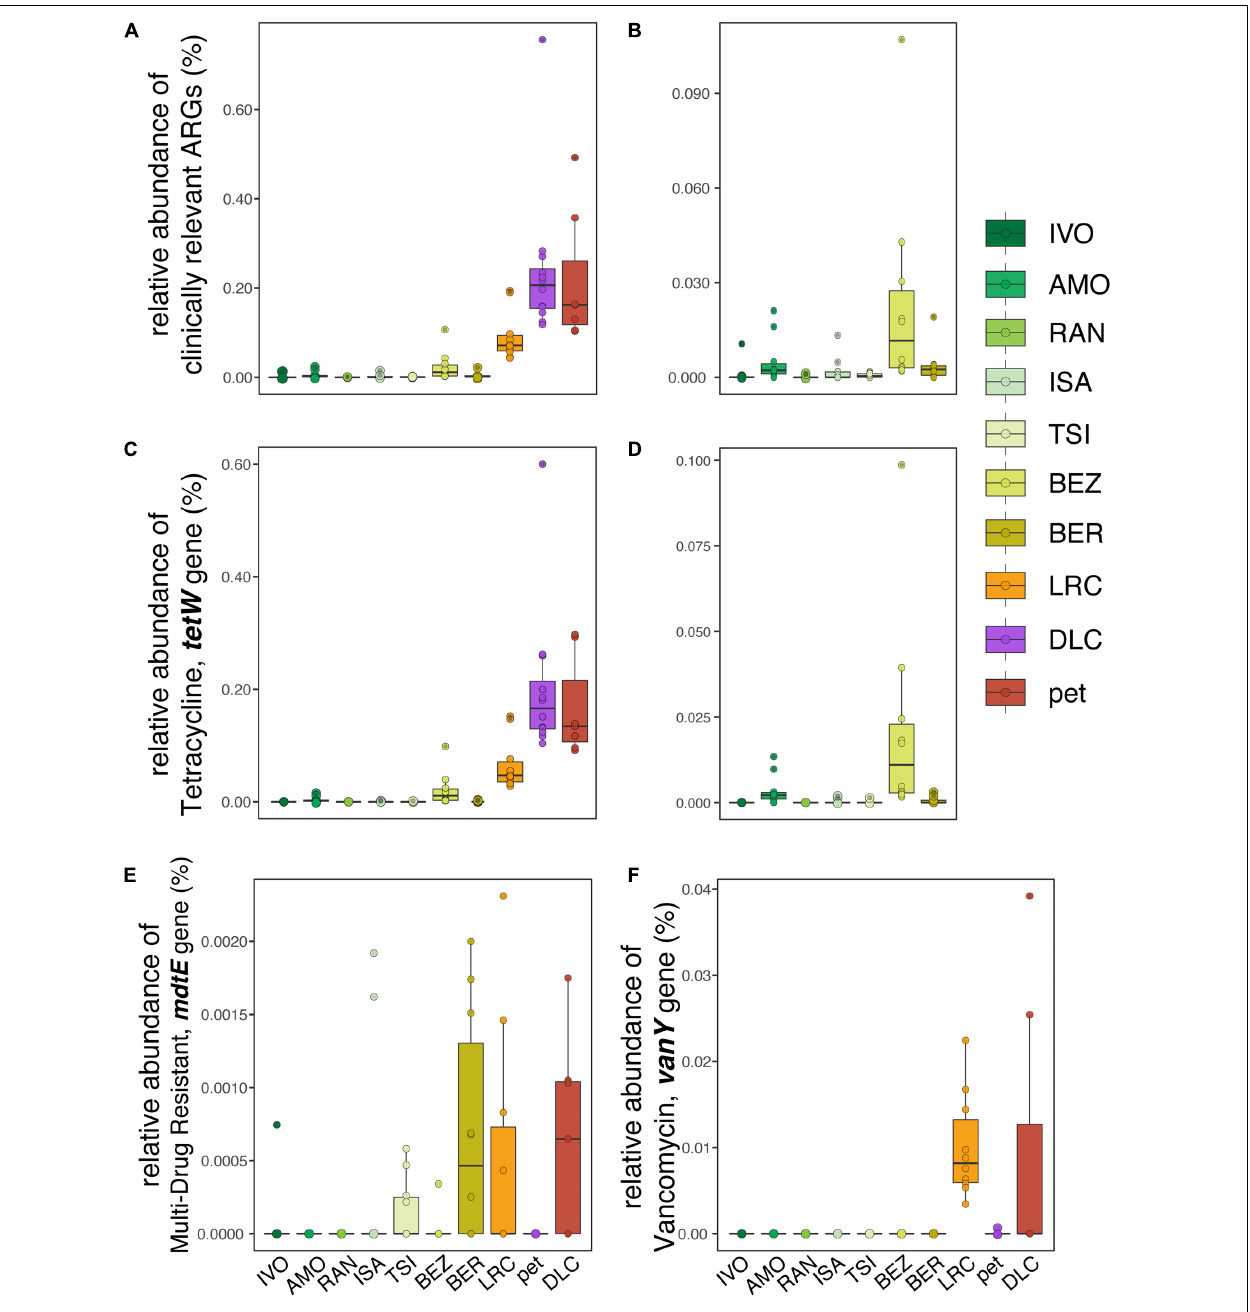
FIGURE 4 | Relative abundances of (A,B) clinically relevant ARGs, including (C,D) tetracycline resistance gene, tetW in the gut microbiota of (A,C) all ring-tailed lemurs ( Lemur catta ) versus (B,D) only wild lemurs, across sites ranked by increasing level of anthropogenic disturbance (see Table 1 ). Also shown are the relative abundances of (E) multi-drug resistant gene mdtE and (F) vancomycin-resistant gene, vanY, for lemurs at all